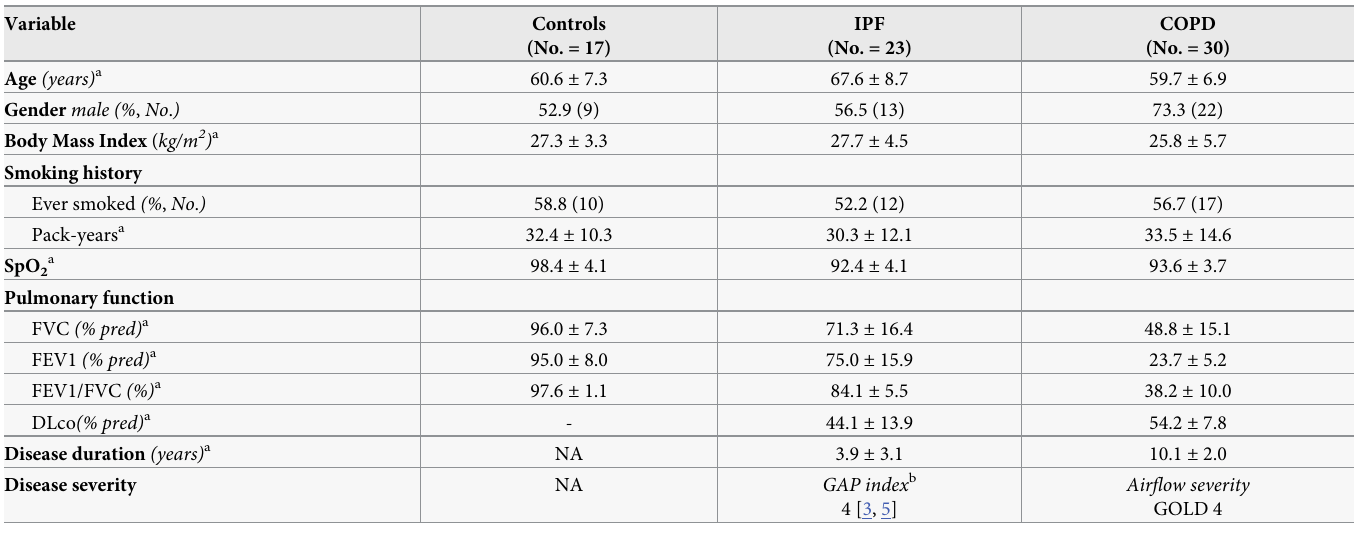
Table 1. Clinical characteristics and physiology of